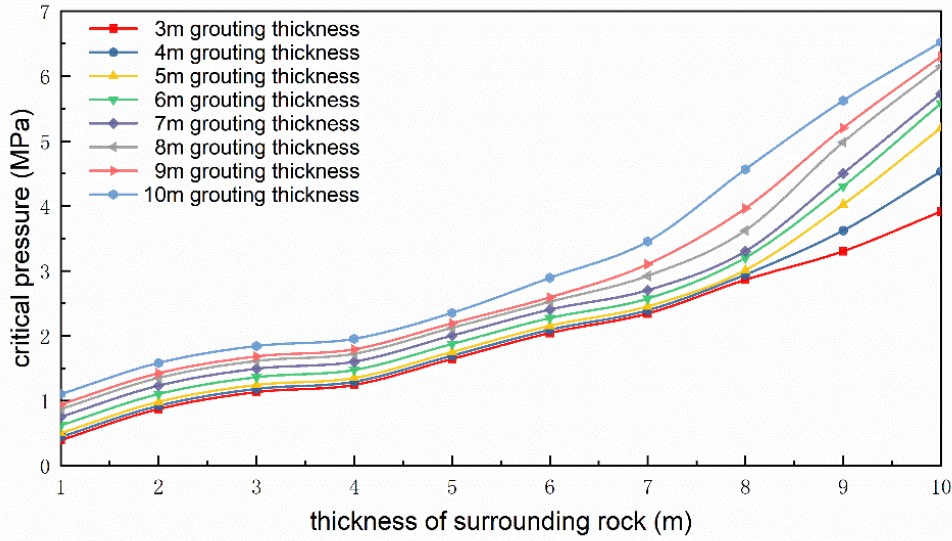
Figure 16. Comparison of water pressure resistance of different composite rock thicknesses.